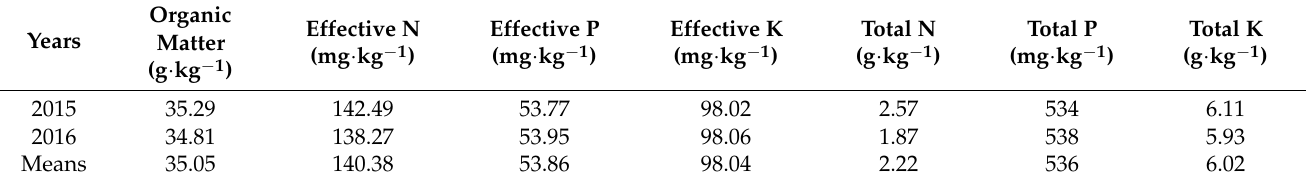
Table 2. The chemical properties of soil on the